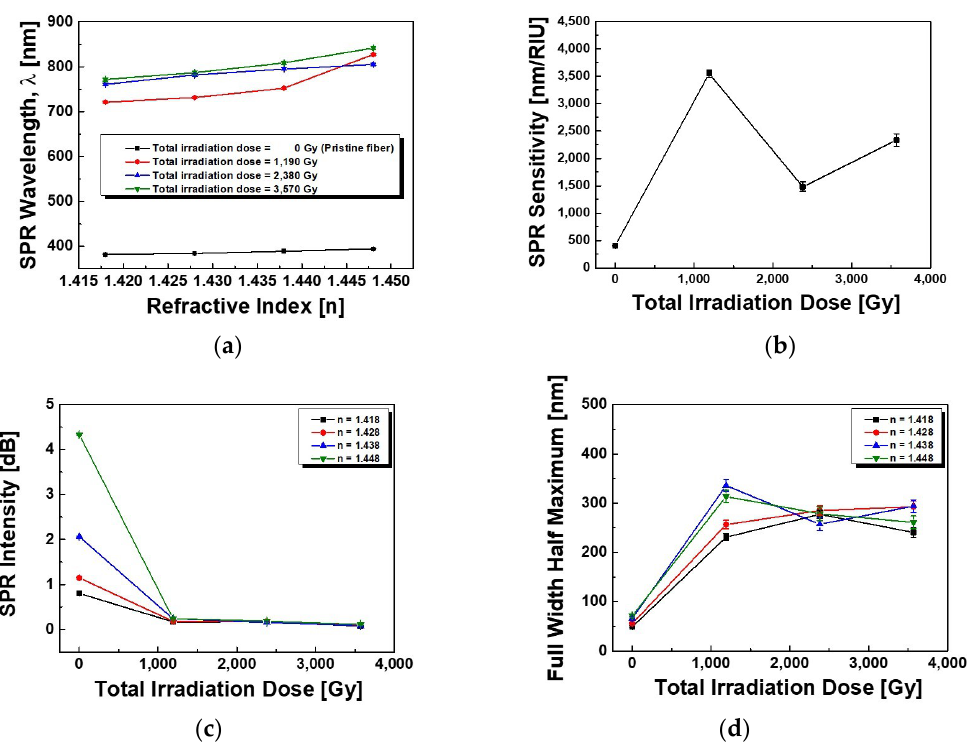
Figure 6. Variation of ( a ) the SPR wavelength, ( b ) the SPR sensitivity, ( c ) the SPR intensity, and ( d ) the FWHM of the SPR spectrum as a function of refractive index of the matching oils before and after the γ‐ray irradiation at the total dose of 1190 Gy, 2380 Gy, and 3570 Gy.